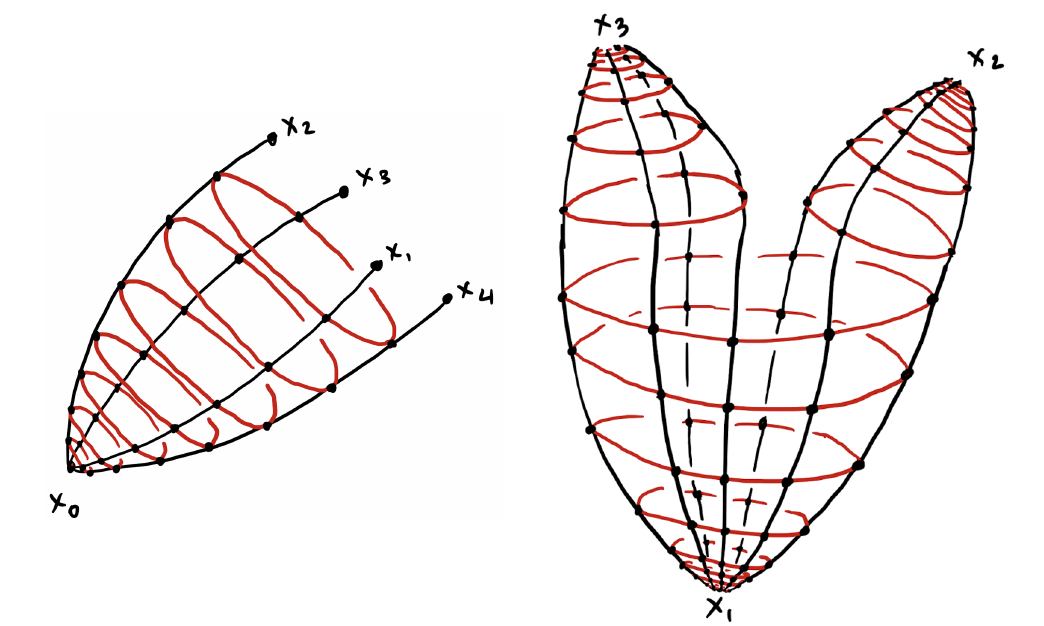
Figure 1 . Left: illustration of a CFT wave function. The point x 0 represents the insertion of the operator and implies the renormalised sum of an infinite ladder of wheel diagrams. Right: 3 CFT wave functions glued together into a 3-point function at finite coupling. The wave functions contain all the nontrivial coupling dependence of the 3-point